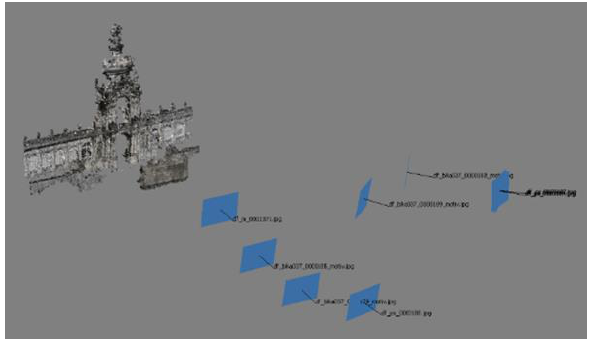
Figure 5. Historical point cloud with camera positions of the images used